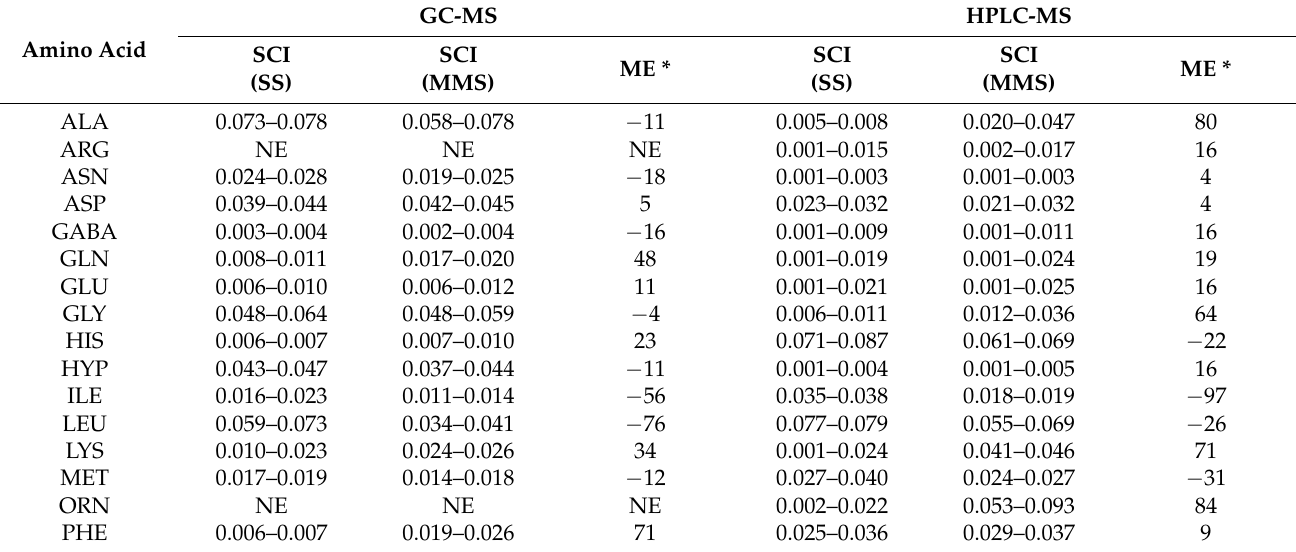
Table 4. Calibration curve data ( n =